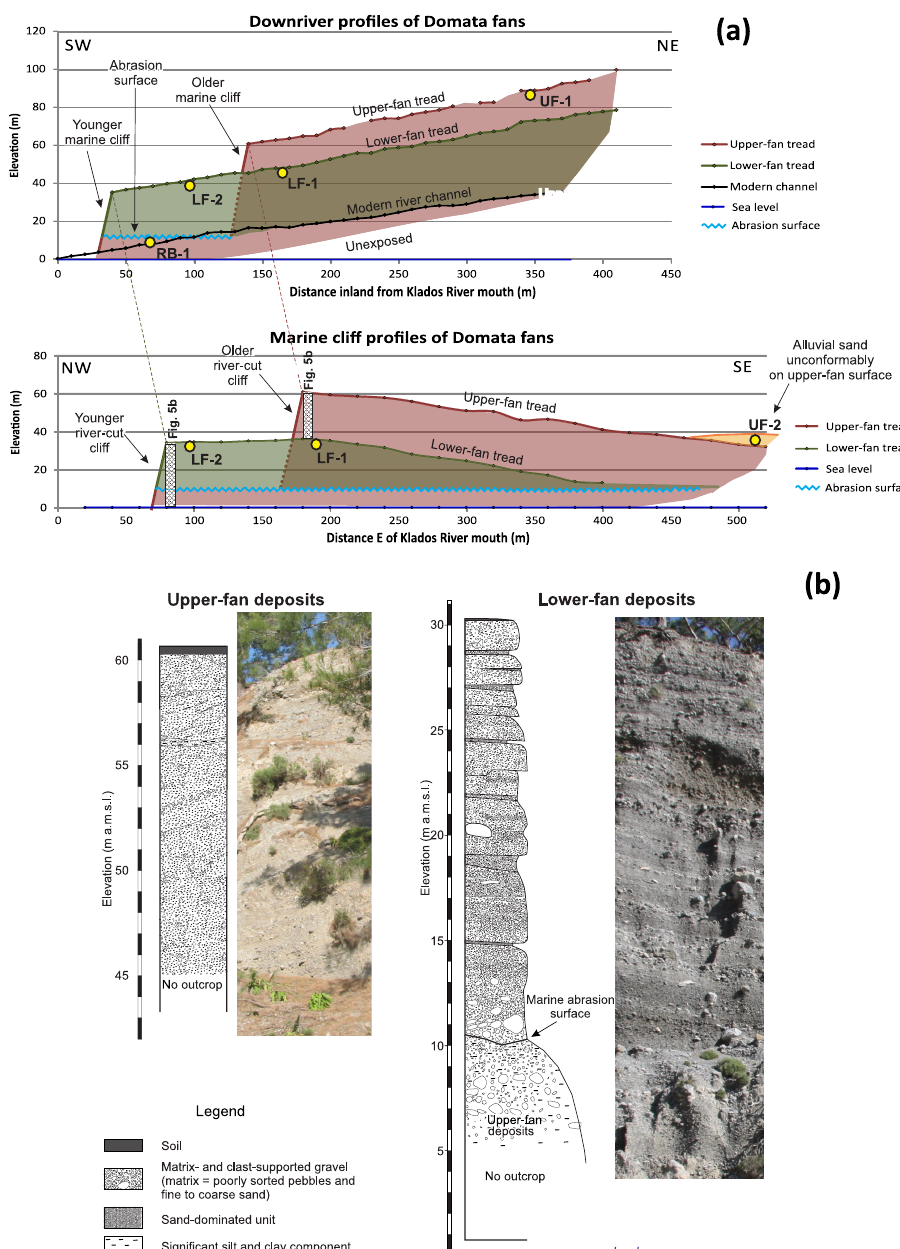
Figure 5. (a) Profiles of fan surfaces projected onto common planes parallel with the modern Klados River channel (above) and parallel with the modern coastline (below). The extent of the volumes of upper-fan materials (pink) and lower-fan materials (light green) are schematically illustrated beneath each measured profile. The locations of each of the luminescence sample points are annotated by yellow dots. The locations of the stratigraphic columns presented in Fig. 5b are also indicated. Horizontal and vertical scales for each profile are similar, with a vertical exaggeration (VE) of ca. 1.25. Note that the downstream slope of the upper- and lower-fan surfaces are about the same, both a little steeper than the slope of the modern stream channel. (b) Schematic stratigraphic columns for the upper (left) and lower (right) alluvial fan deposits. Note that vertical scale bars indicate elevation in metres above mean sea level for each column. The lower-fan column reflects a stratigraphic section close to the junction between the lower-fan coastal cliff and the river entrenchment. The upper-fan section is located close to the western end of the marine cliff. Their stratigraphic location is indicated in Fig. 5a. Note that the right-hand edge of the lower-fan section represents relative competence of